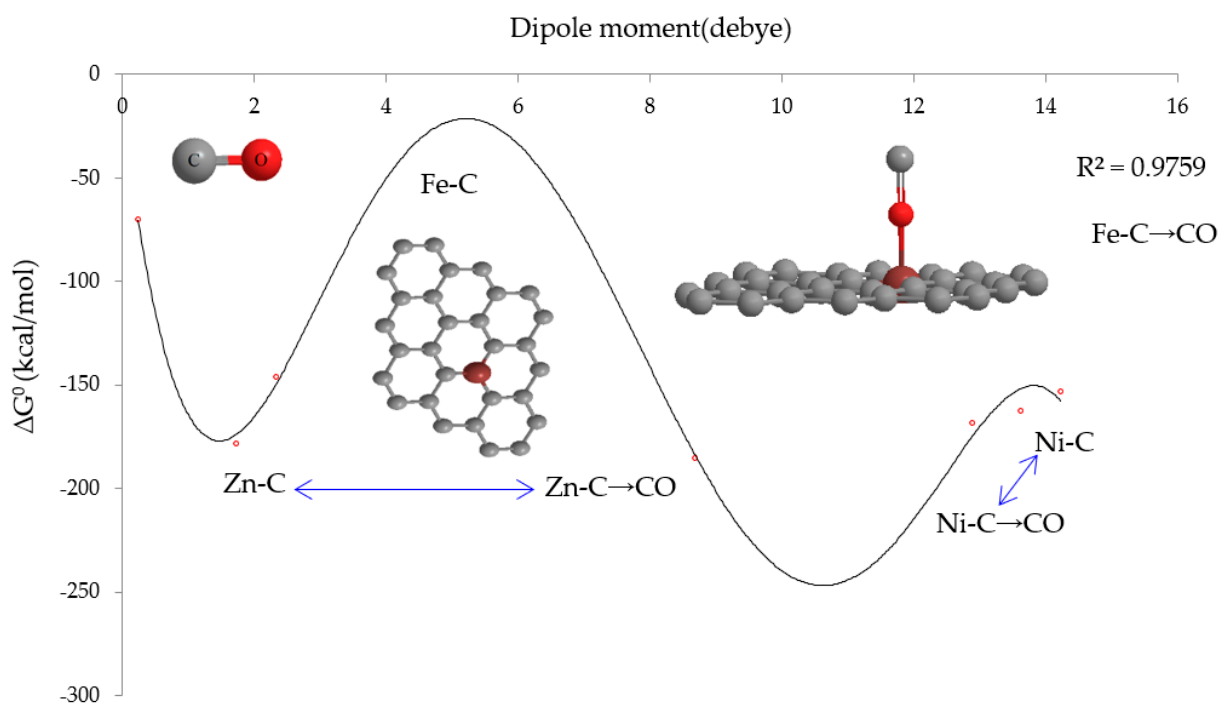
Figure 4. The changes of Gibbs free energy for the adsorption of CO as a toxic gas on TM (Fe, Ni, Zn)-doped graphene nanosheets.